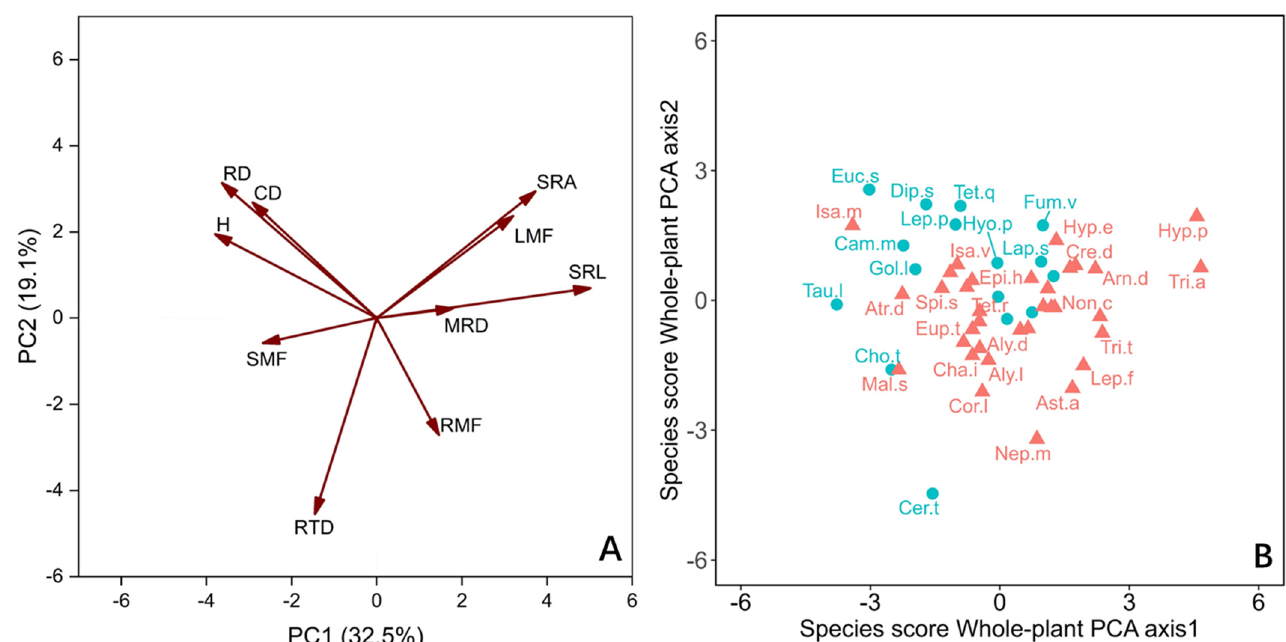
Figure 3. Principal component analysis (PCA) with the mean values (n = 10) of the whole-plant traits, of 50 annual ephemeral species growing in either loose sand or dense, gravelly sand in the cold desert of the Chinese Junggar Basin in 2022. ( A ) PCA with the mean of 10 values of the whole-plant traits. ( B ) Score of species along the first two axes of whole plant. Species names are given as abbreviations (see Table 2). The red triangles and ellipses represent species rooting in loose sand (LS). The blue dots and ellipses represent species rooting in gravelly or dense sand (DGS). The meanings of H, CD, MRD, RD, SRL, SRA, RTD, LMF, SMF and RMF are plant height, root collar diameter, maximum root depth, root diameter, specific root length, specific root area, root tissue density, leaf mass fraction, stem mass fraction, and root mass fraction, respectively. Table 1. Differences in principal component (PC) 1 and PC2 scores between ephemeral species rooting in loose sand (LS; n = 34) or gravelly or dense sand (DGS; n = 16) and (mean ± SE) in the cold desert of the Chinese Junggar Basin in 2022.